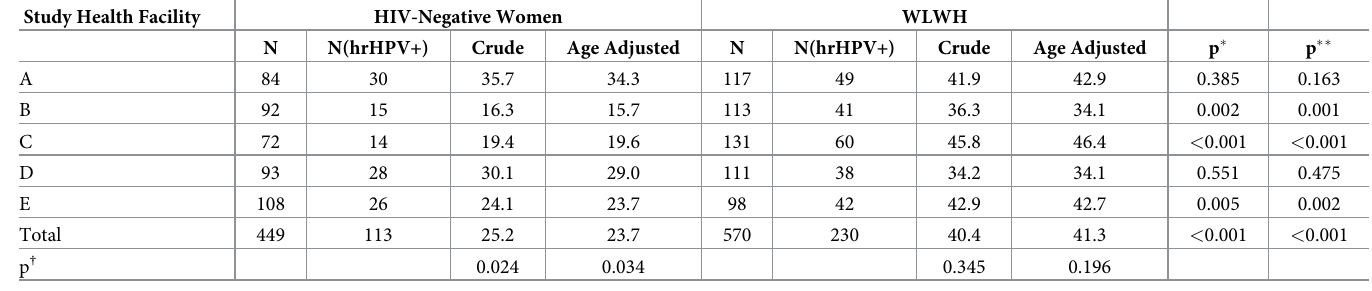
Table 2. High-risk human papillomavirus (hrHPV) prevalence by health facility and human immunodeficiency virus (HIV) status. Abbreviations: WLWH, women living with HIV. Study Health Facility